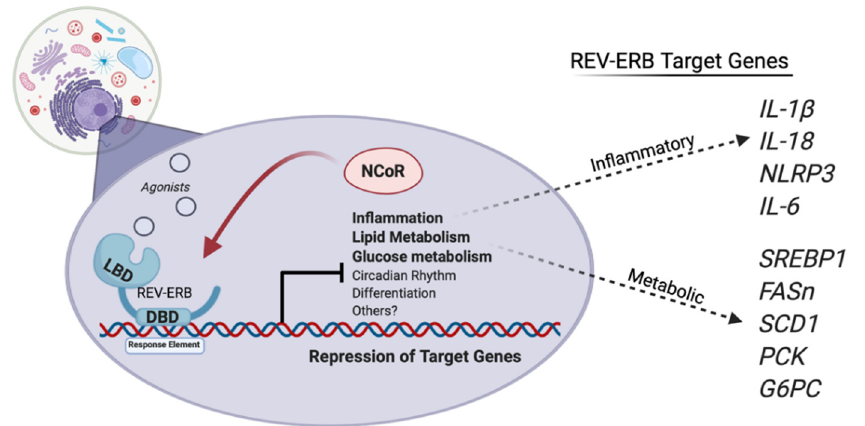
Figure 10. REV-ERBs regulate the transcription of genes involved in the activation of the NLRP3 inflammasome and genes that regulate liver metabolism. REV-ERB activation suppresses proin- flammatory genes involved in the progression from steatosis to steatohepatitis, reducing circulating cytokines and inhibiting the activation of the NLRP3 inflammasome. Additionally, activating REV- ERB pharmacologically suppresses lipid and glucose metabolism, and may provide a beneficial effect for those also suffering from hyperglycemia and obesity. Figure created with BioRender (accessed on 7 February